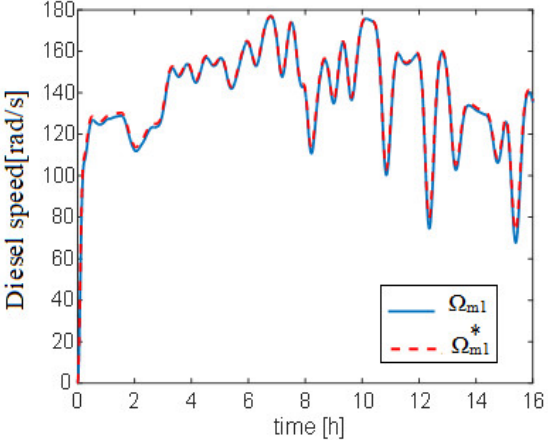
Figure 19. Result of diesel engine speed control.